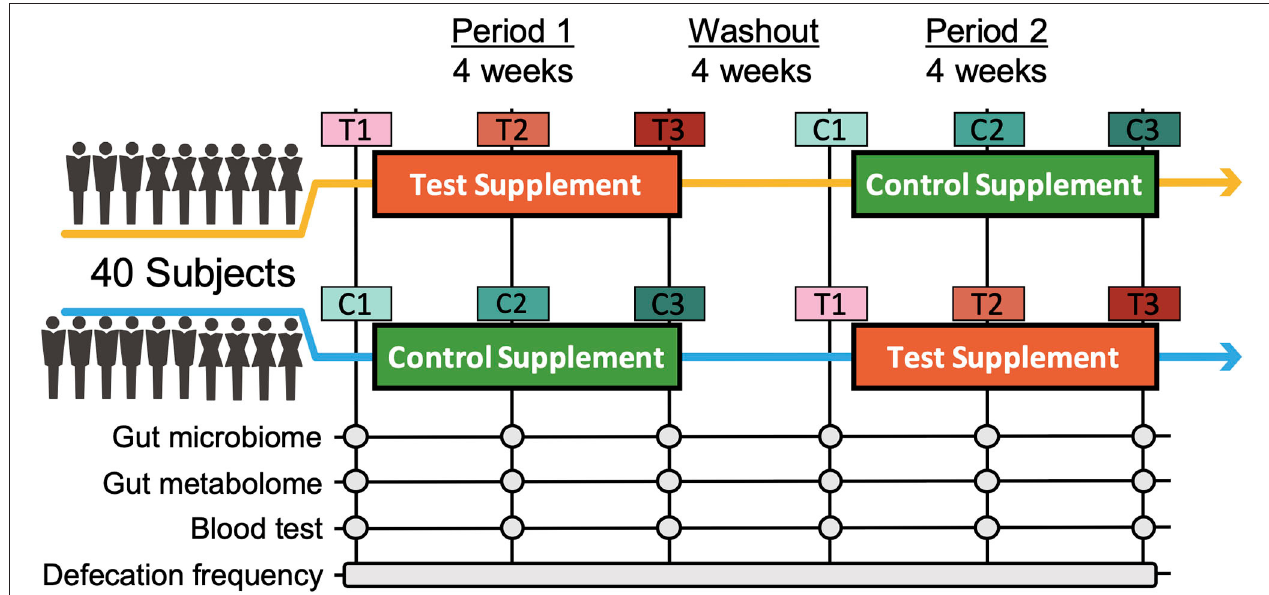
FIGURE 1 | Timeline of the double-blind randomized crossover trial. Two 4-week dietary treatments were set in succession. The dietary intervention periods were interspaced by a 4-week washout period. Blood and faecal samples were collected beforehand and at week 2 and 4 of each intervention period. C and T indicate the control and test supplement intervention periods, respectively, and number 1-3 indicates the sampling timepoint in the period.